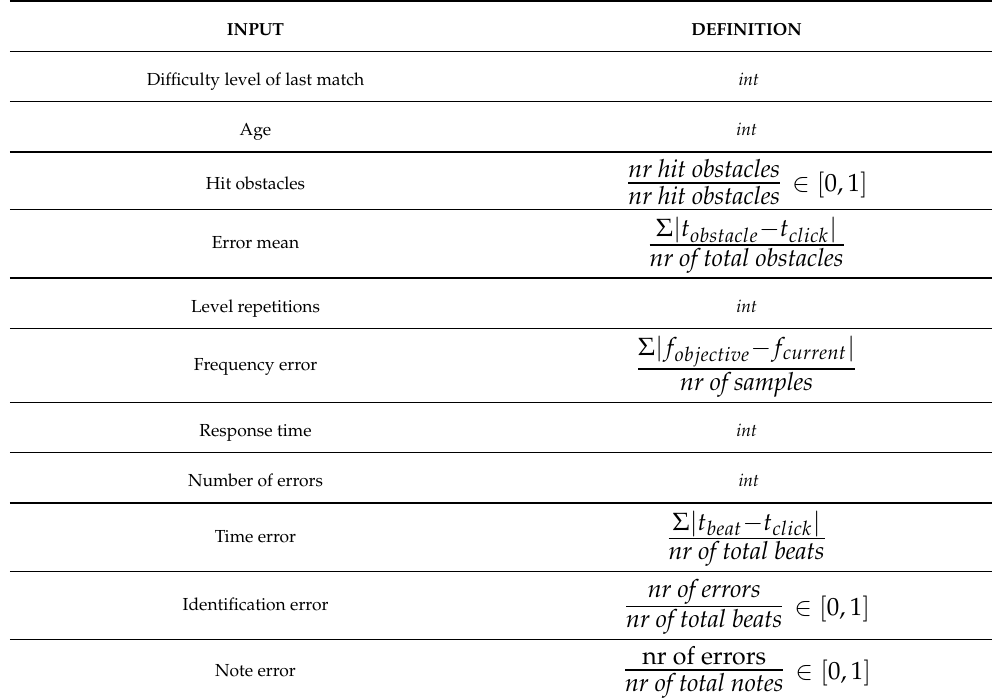
Table 3. Definitions of the Neural Network